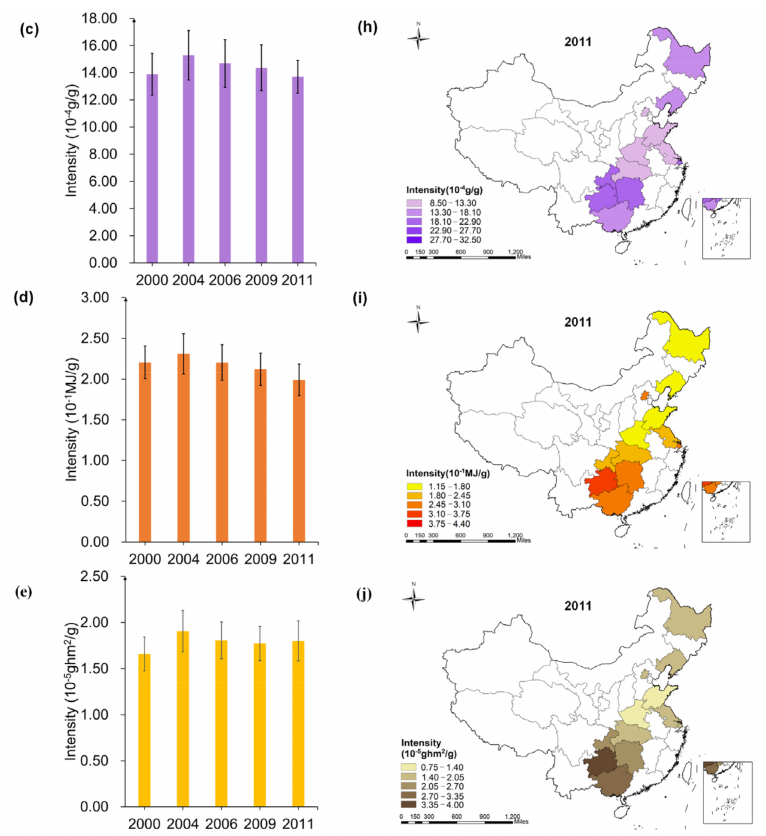
Figure 6. Spatial-temporal characteristics of multiple footprint intensity of insoluble dietary fiber in- take ( a , f ): WF; ( b , g ): CF; ( c , h ): NF; ( d , i ): EF; ( e , j ): LF; The error lines in the figure are standard errors).